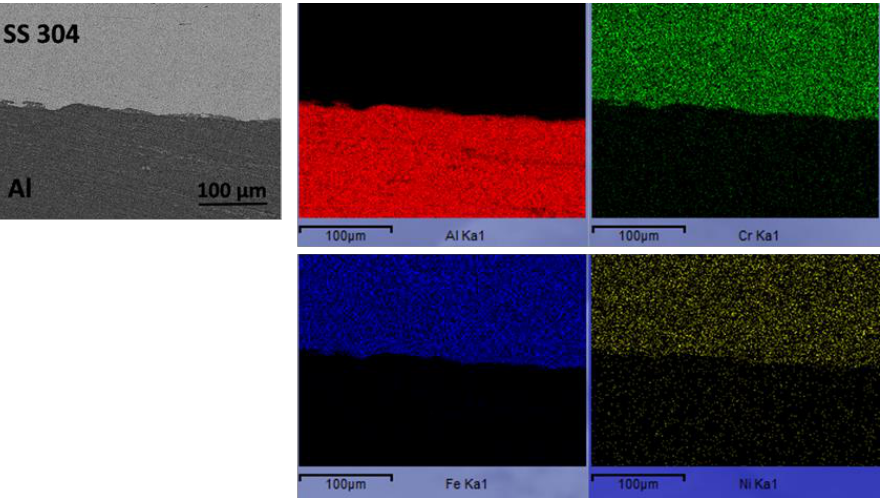
Figure 10. Surface EDS map of the bi-metallic MPW joint.